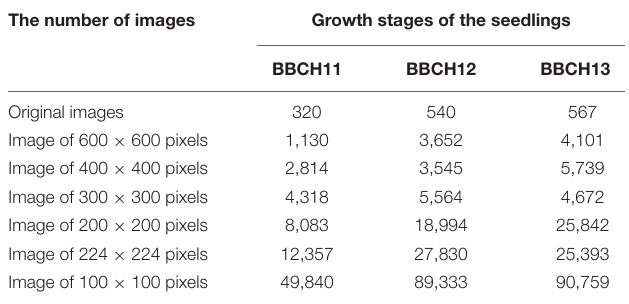
TABLE 2 | Detailed information of the